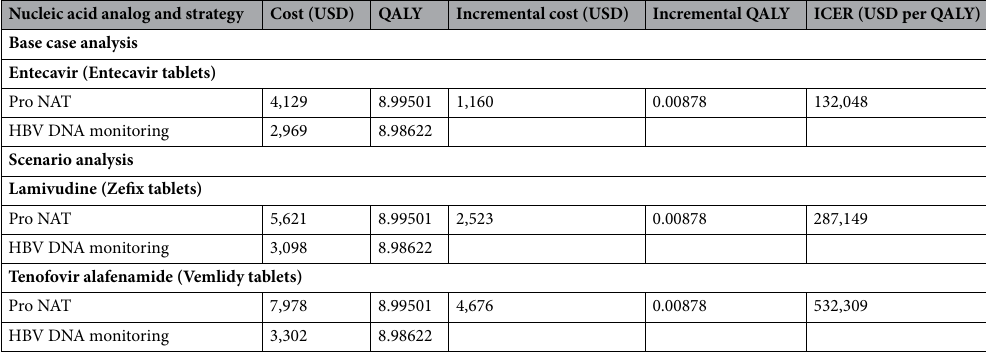
Table 1. Results of a base-case analysis and scenario analysis. HBV DNA monitoring: HBV DNA monitoring followed by on-demand antiviral therapy; ICER: incremental cost-effectiveness ratio; Pro NAT: prophylactic anti-HBV nucleos(t)ide therapy; QALY: quality-adjusted